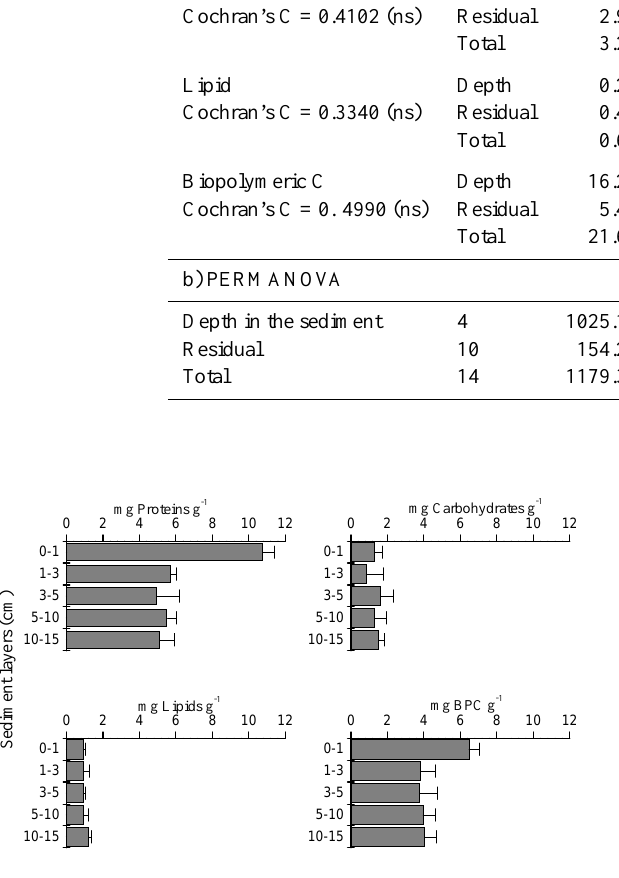
Fig. 3. Vertical distributions of the main biochemical classes of organic compounds (proteins, carbohydrates, lipids) and biopoly- meric C (the sum of carbon within these compounds) in the sed- iment. Standard deviations are indicated. Data are expressed in milligrams per g of sediment dry weight ( n = 3).